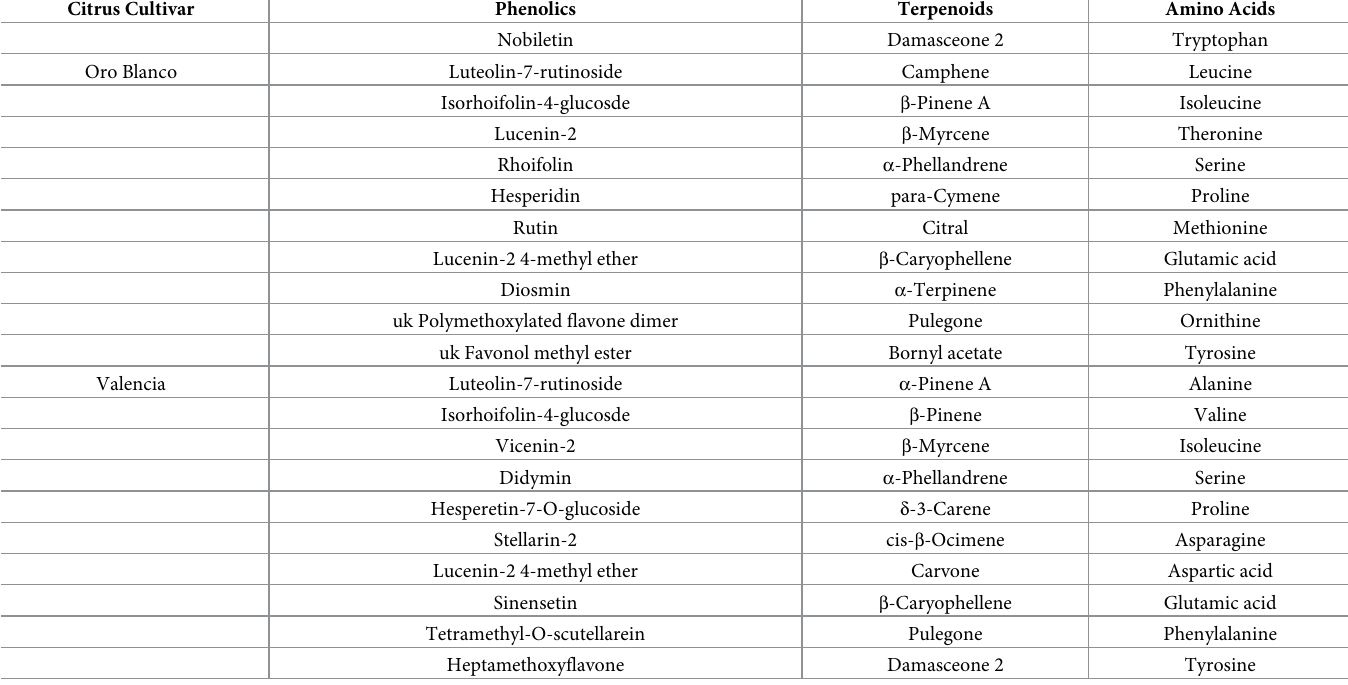
Table A in S1 Appendix. CDAs of different cultivars with phenolics, terpenoids, and amino acids were able to predict the correct cultivar of each sample with at least 98% accuracy for each metabolite class (Table B in S1 Appendix). This highlights the significant differences of these various metabolites across the difference citrus cultivars used. Due to the significant dif- ferences, CDA of CTV status was done separately for each cultivar. Consequently, the optimal phenolics, terpenoids, and amino acids for CDA differed between each citrus cultivar (Table 2). Canonical plots generated from CDA utilizing phenolics revealed that healthy citrus tended to cluster further from CTV-infected citrus, with citrus infected with mild and severe strains of CTV clustering more closely together (Fig 8). This was true in most cultivars, except in Lisbon and Navel. Though mild-CTV citrus tended to cluster more closely with severe-CTV citrus, they still effectively clustered separately. Samples belonging to a particular CTV status clus- tered correctly, with at least 97% overall accuracy across cultivars (Table 3). CDA of CTV status with terpenoids produced similar results compared to phenolics. Canonical plots generated from CDA using terpenoids show that all treatment types clustered separately from one another, with mild and severe CTV-infected citrus clustering more closely together than with healthy citrus (Fig 9), just as with phenolics. This was true for most culti- vars, except Navel and Oro Blanco. Overall, samples were assigned to the correct treatment within each cultivar with high accuracy (Table 4). Most cultivars had their samples correctly assigned with 97% accuracy, while Minneola and Navel displayed 90% and 87% correct assign- ments of samples,